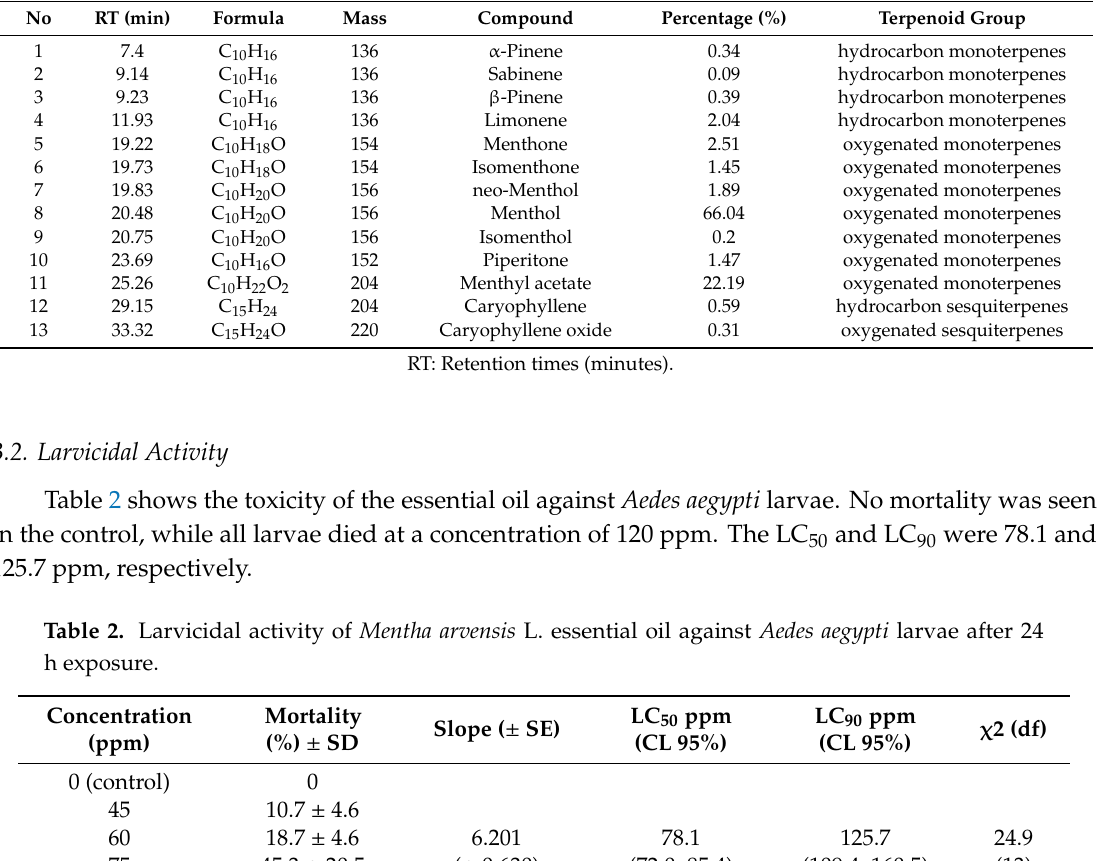
Table 1. Chemical constituents (%) of Mentha arvensis L. essential oil.